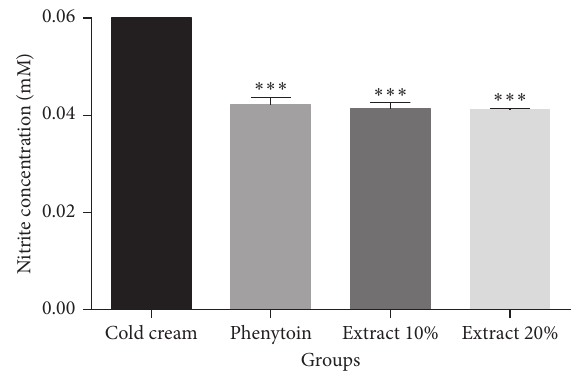
Figure 4: Nitrite concentrations (mm) of serum samples taken on day 14 after wound creation in each group. Cold cream: negative control group; phenytoin: phenytoin-treated group; extract 10%: 10% PPE-treated group; extract 20%: 20% PPE-treated group. ∗∗∗ P < 0 . 001, vs. cold